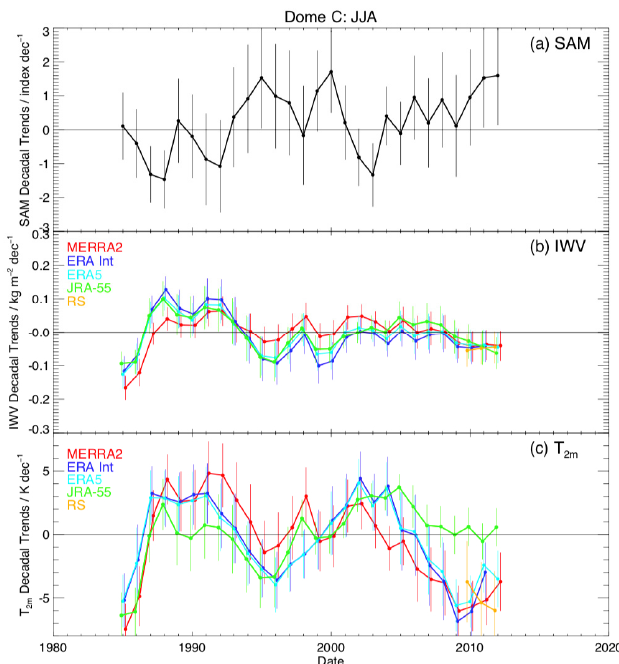
Figure 11. Multidecadal variability of the 10-year trends of ( a ) the SAM index, ( b ) the IWV and ( c ) the near-surface temperature (T 2m ) from the MERRA2 (red), ERA interim (dark blue), ERA5 (light blue) and JRA-55 (green) reanalyses above Dome C from 1980 to 2017 in winter (JJA). Superimposed are the 10-year trends of the IWV ( b ) and the 10-m temperature ( c ) from the radiosonde data set (orange) from 2005 to 2017. Vertical bars represent 1- σ error.